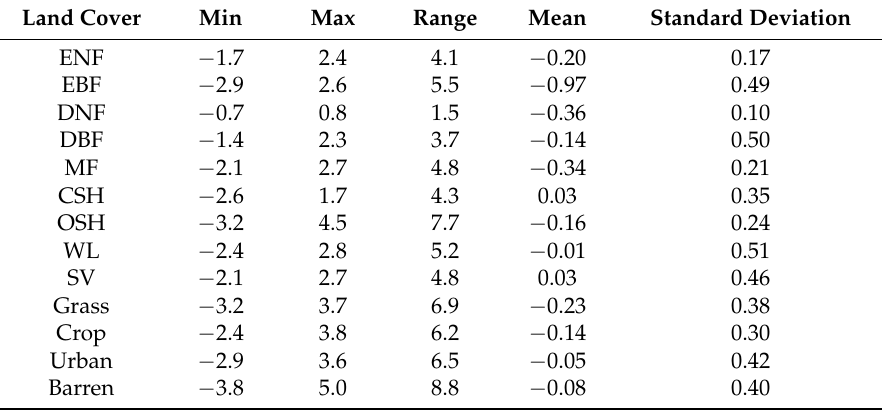
Table 5. Summary statistics for the difference (mm day − 1 ) between ET LST estimates and MODIS ET averaged over the period 2001–2013 based on 2001 land